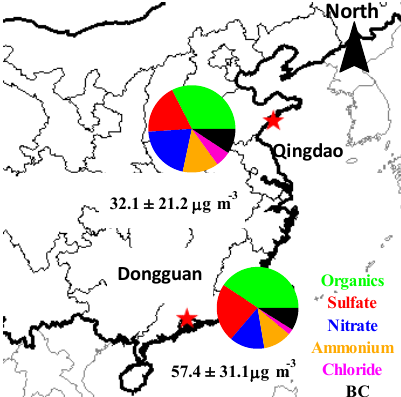
Figure 1. The locations and the average PM 1 chemical composi- tions of the Qingdao and Dongguan sampling